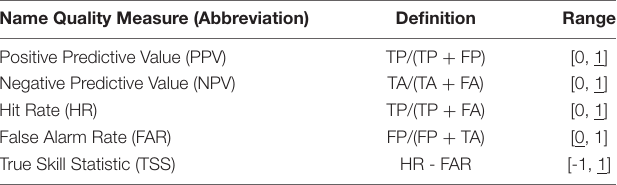
TABLE 2 | Verification